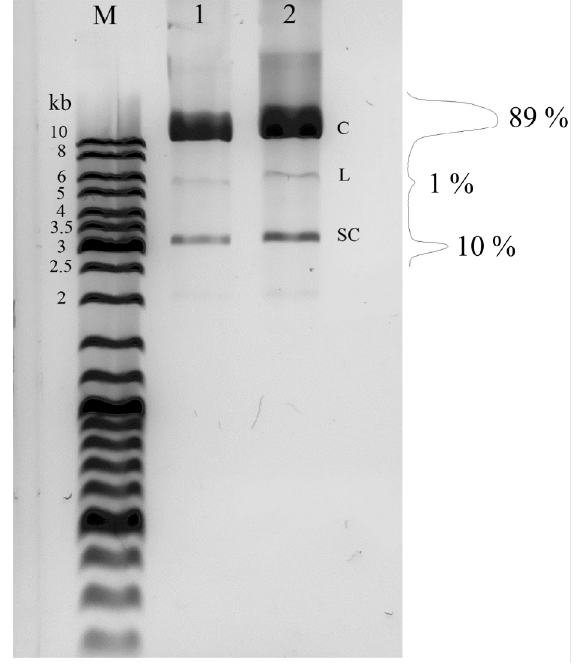
Figure 1. Electrophoresis of pET-11c plasmid DNA and its distribution by fractions: C—circular DNA, L—linear DNA, SC—supercoiled DNA. The original data are in Supplementary file